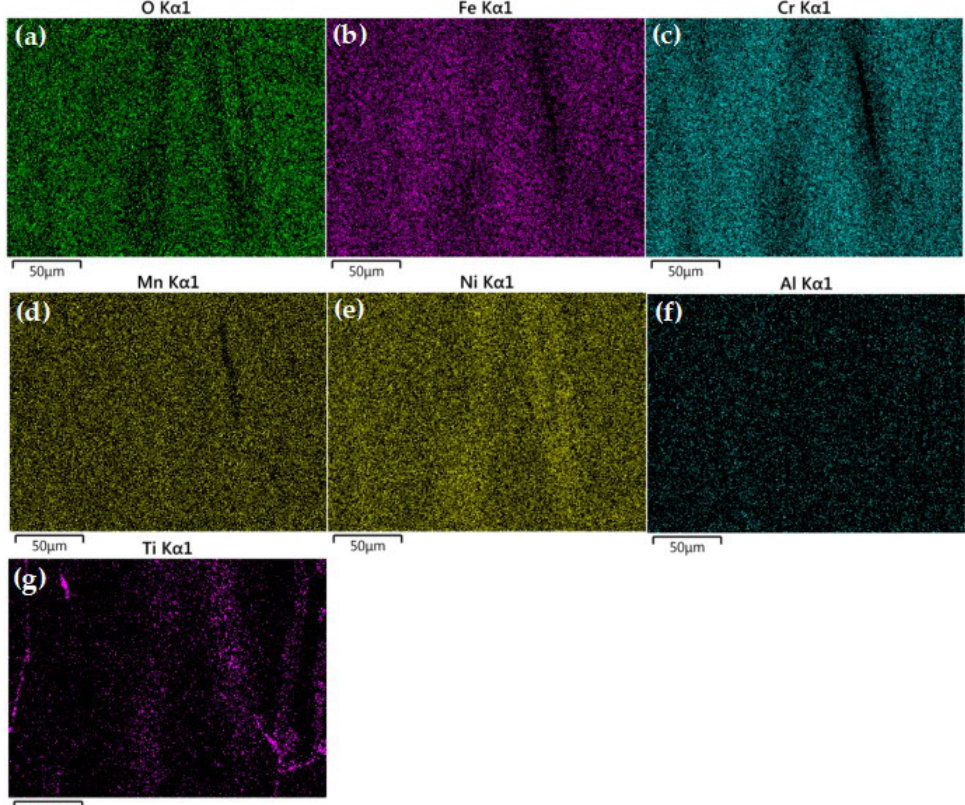
Figure 9. Surface scan of the (FeNi)67Cr15Mn10Al5Ti3 alloy after corrosion in a 360 °C high- temperature and high-pressure water environment for 14 days: ( a ) Distribution diagram of O; ( b ) Distribution diagram of Fe; ( c ) Distribution diagram of Cr; ( d ) Distribution diagram of Mn; ( e ) Distribution diagram of Ni; ( f ) Distribution diagram of Al; ( g ) Distribution diagram of Ti.